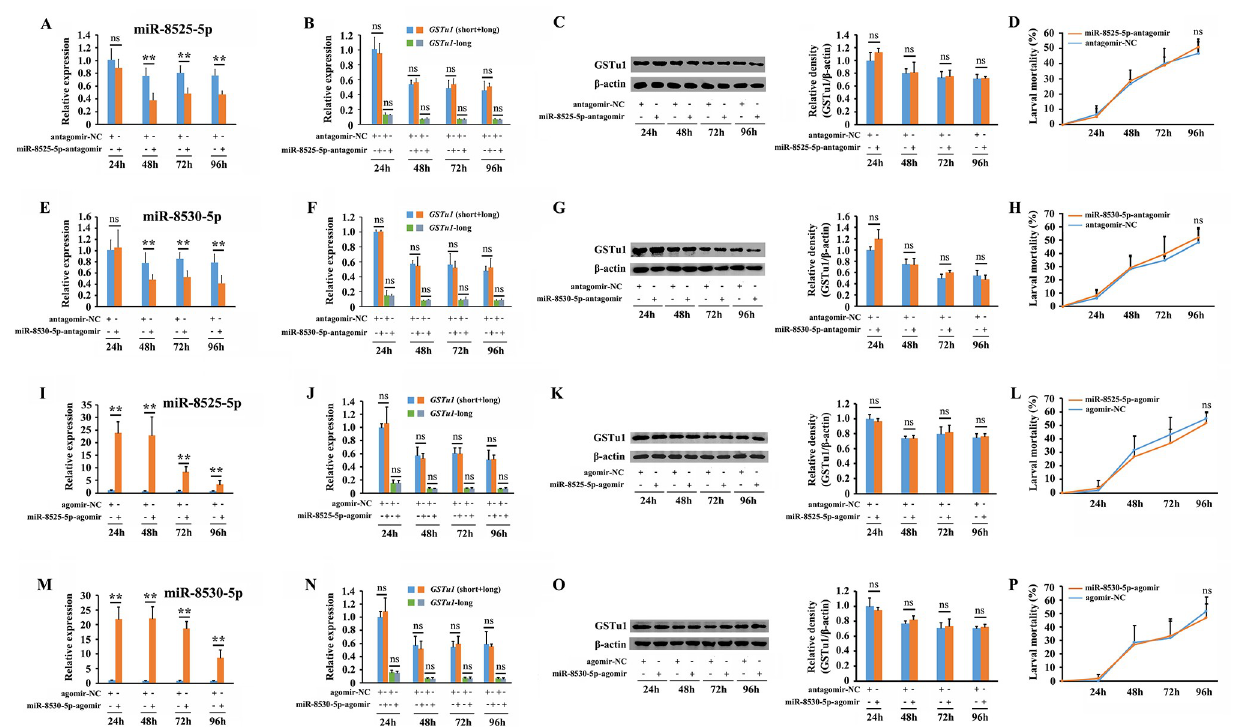
Fig 6. Effect of the upregulation and downregulation of miR-8525-5p or miR-8530-5p alone on the expression of GSTu1. Effects of miR-8525-5p antagomir/agomir treatment on the expression of miR-8525-5p (A, I) and GSTu1 (B, C, J, K) by qRT-PCR and Western blotting, as well as changes in susceptibility to chlorantraniliprole (D, L). Effects of miR-8530-5p antagomir/agomir treatment on the expression of miR-8530-5p (E, M) and GSTu1 (F, G, N, O) by qRT-PCR and Western blotting, as well as changes in susceptibility to chlorantraniliprole (H, P). Asterisks indicate significant differences between the treatment and the corresponding control (Student’s t -test, ns indicates no significant differences, � 0.01 < P < 0.05, �� P < 0.01).